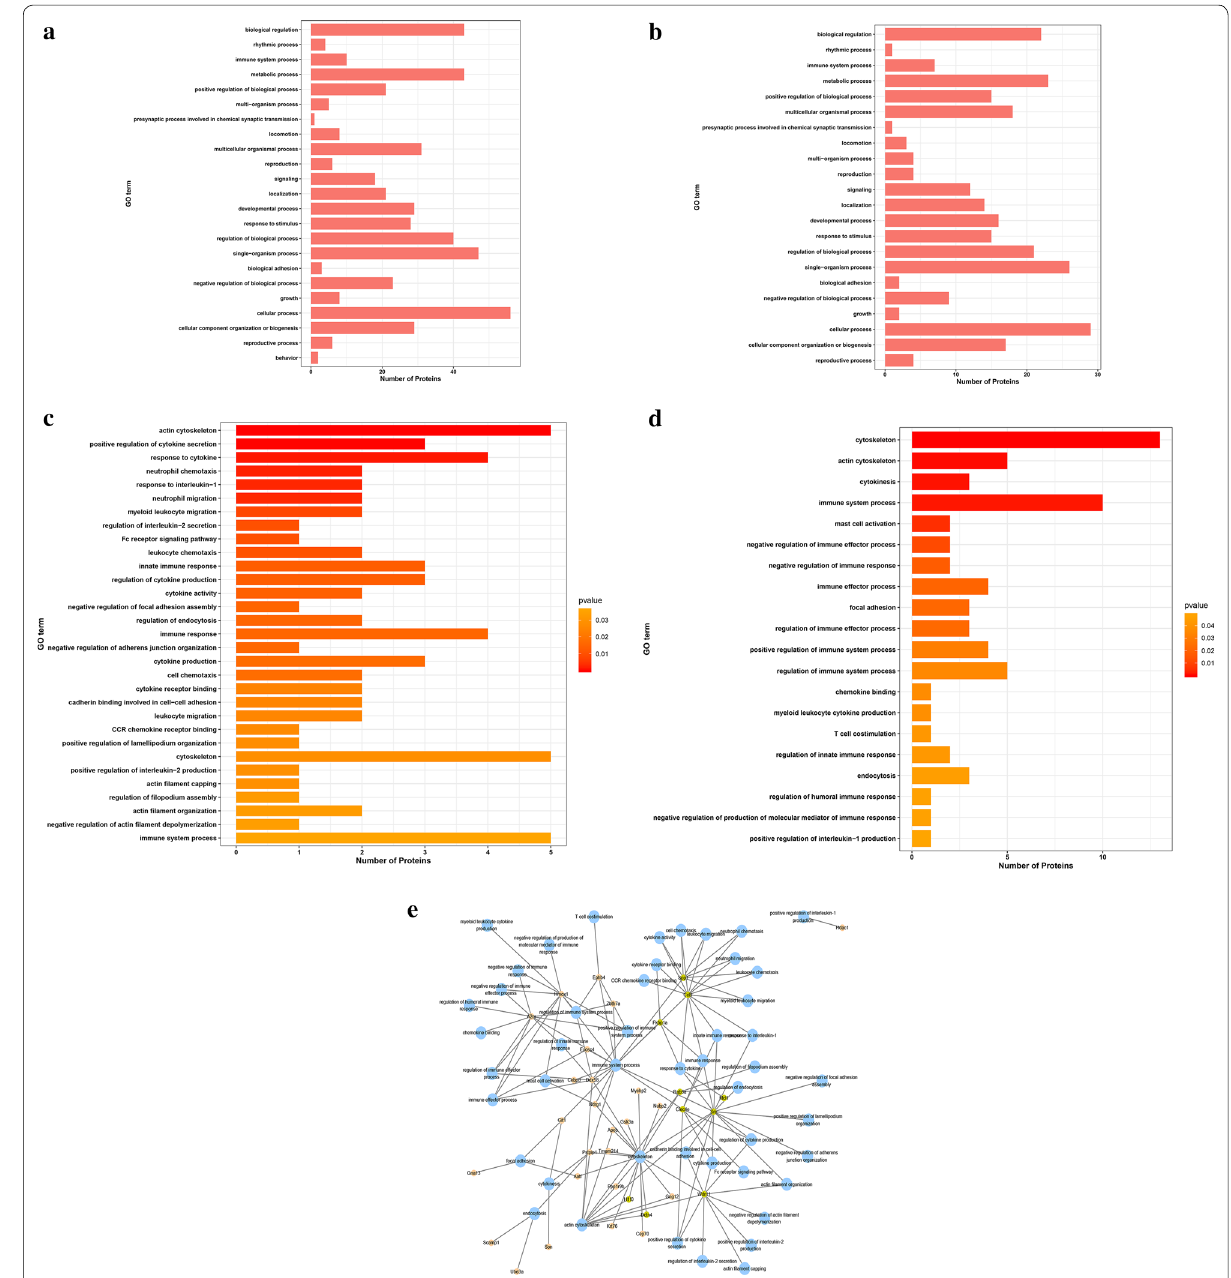
Fig. 2 GO analysis of differentially expressed proteins. a Upregulated proteins were categorized into the level 2 biological process GO terms. b Downregulated proteins were classified into level 2 biological process GO terms. c Immunity related downregulated proteins from the GO enrichment analysis. d Immunity related upregulated proteins from the GO enrichment analysis. e Connections of the upregulated and downregulated immunity related proteins. Green circle indicated the downregulated protein, orange circle indicated upregulated protein, blue circle represented the GO